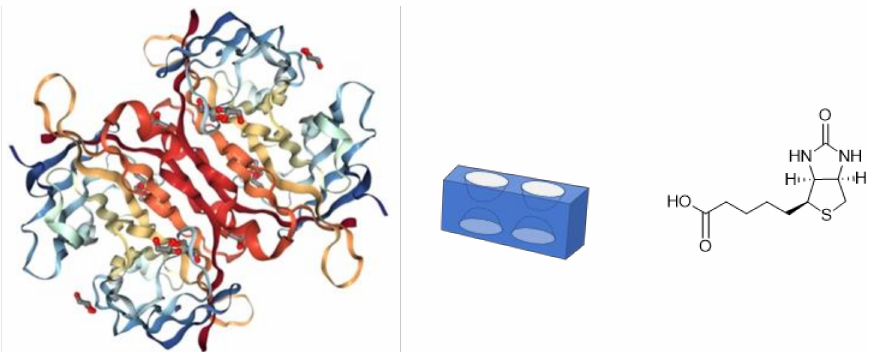
Figure 1. Crystal structure of avidin ( left ), its cartoon representation highlighting the biotin recogni- tion sites on opposite facets ( center ), and chemical structure of biotin ( right ). The structure of the protein (from the Protein Data Bank, code 5CHK) shows the presence of glycerol on the outside, used in the crystallization